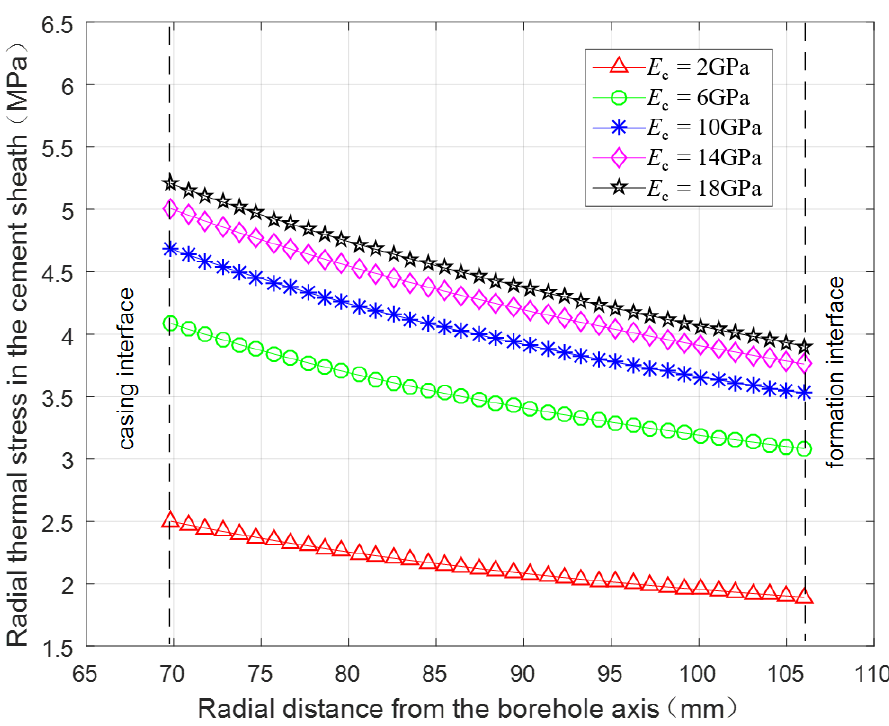
Figure 13. Radial distribution of the radial thermal stress in the cement sheath under different elasticity moduli of the cement sheath.